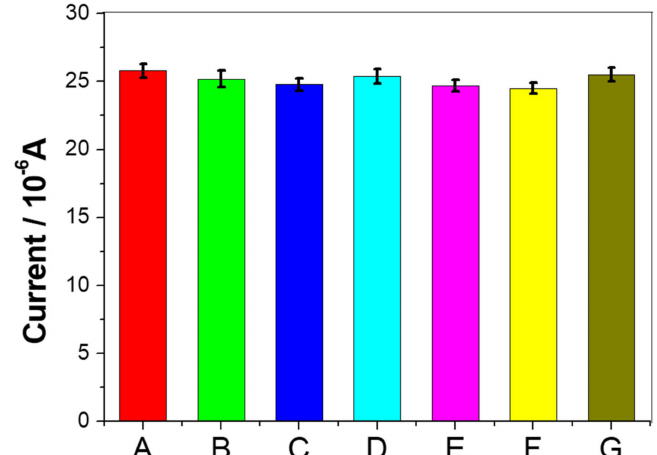
Figure 6. Study of the specificity of the immunosensor towards various interfering